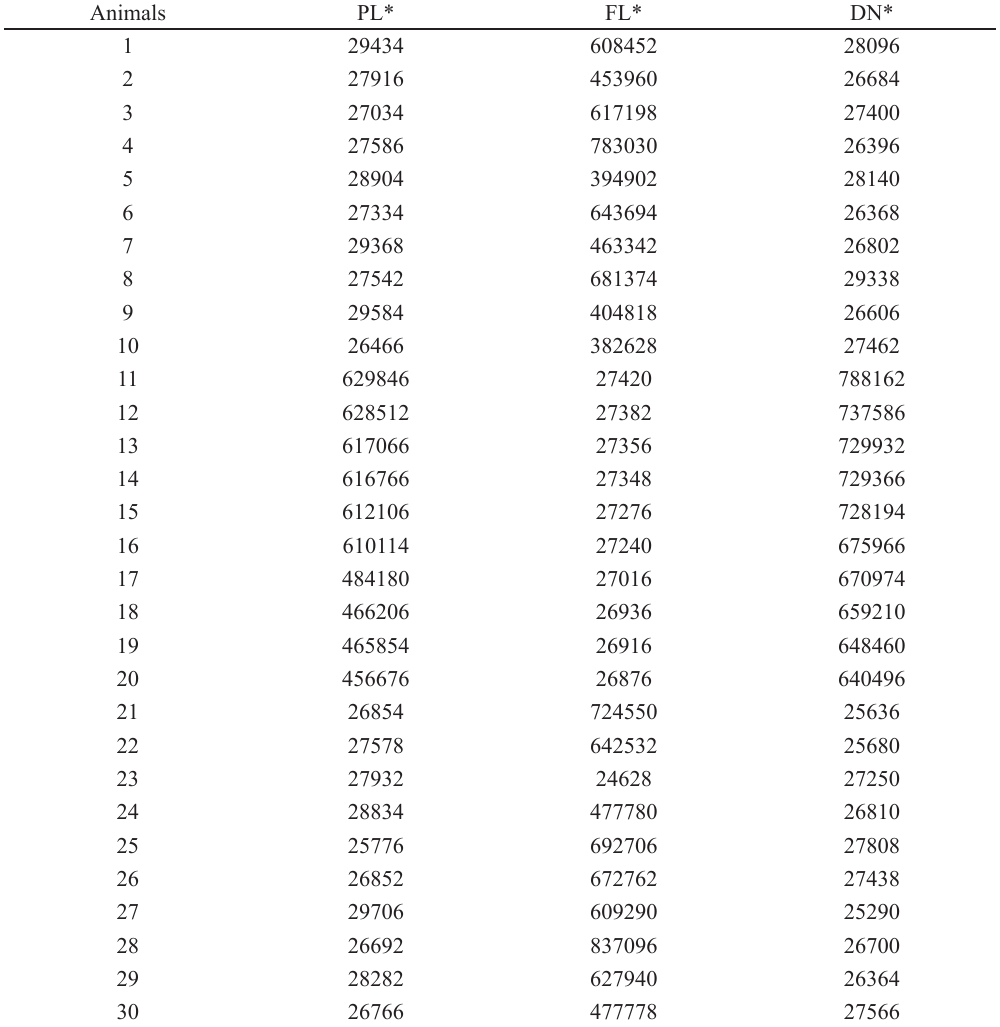
Fish ranking within the families based on high genetic values for live weight (g) from 1-10, intermediate genetic values from 11-20 and lower genetic values from 21-30 in the uni-characteristic analyses.